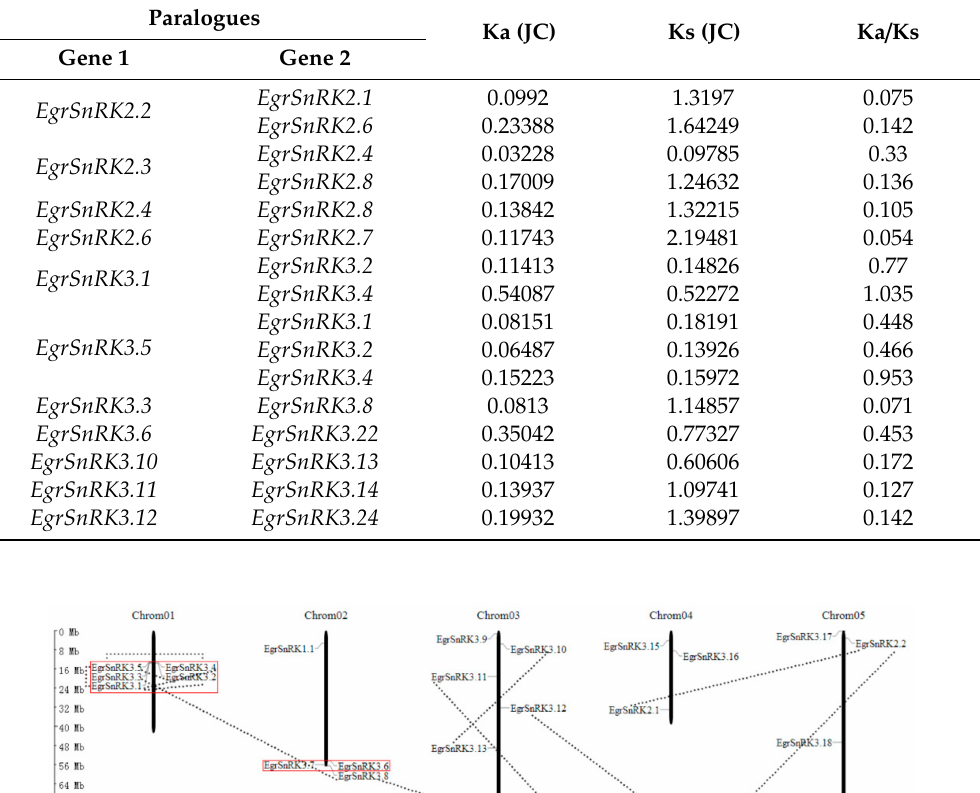
Table 2. Ka / Ks ratios of paralogous genes.